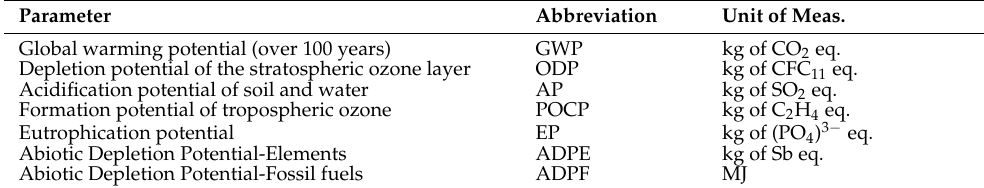
Table 1. Environmental impact parameters related to emissions.